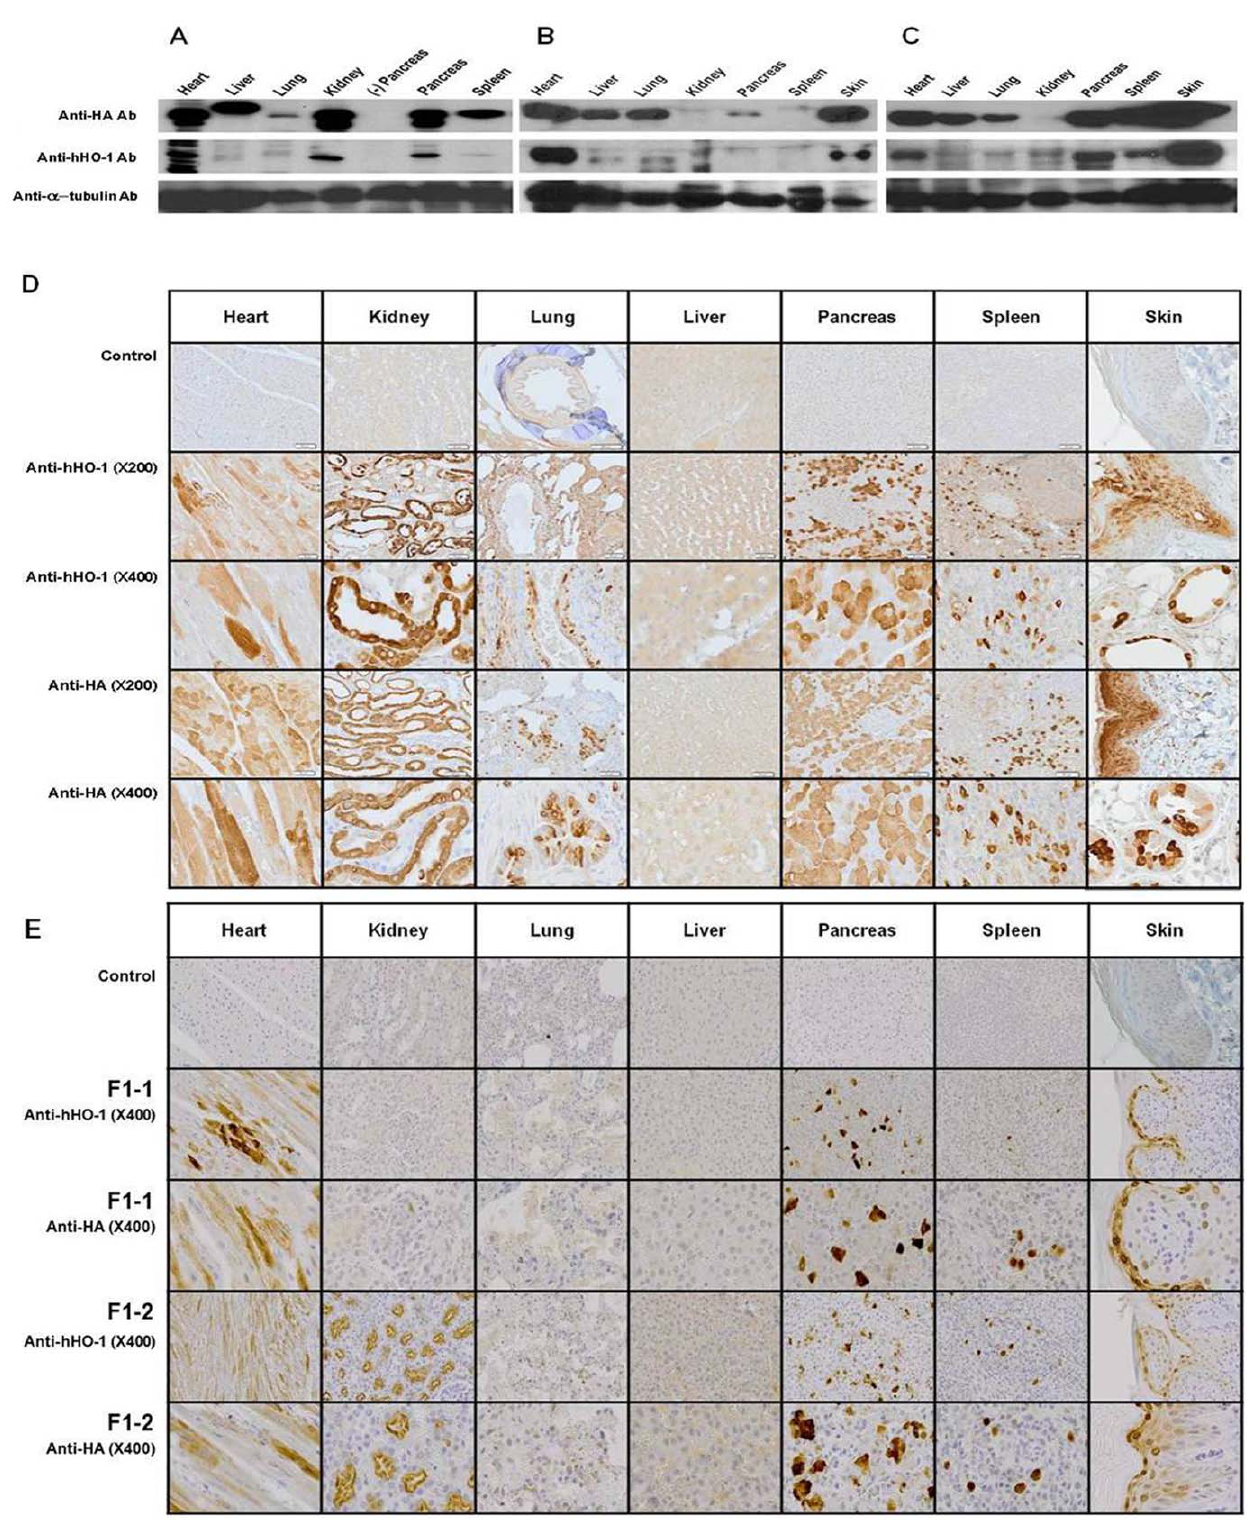
Figure 3. Tissue distribution of hHO-1 protein in hHO-1-Tg pig tissues. A: The tissue distribution of the hHO-1 protein was analyzed in various organs by western blot analysis in a 465-day-old male hHO-1 F0 pig. Western blot was performed on heart, kidney, lung, liver, pancreas, spleen, and skin tissue. B: The tissue distribution of the hHO-1 protein was analyzed in various organs by western blot analysis in a 74-day-old male hHO-1 F1 pig. Western blot was performed on heart, kidney, lung, liver, pancreas, spleen, and skin tissue. C: The tissue distribution of the hHO-1 protein was analyzed in various organs by western blot analysis in a 74-day-old male hHO-1 F1 pig. Western blot was performed on heart, kidney, lung, liver, pancreas, spleen, and skin tissue using anti-hHO-1 (1:1,000) and anti-HA antibodies (1:4,000). Twenty micrograms of protein were loaded